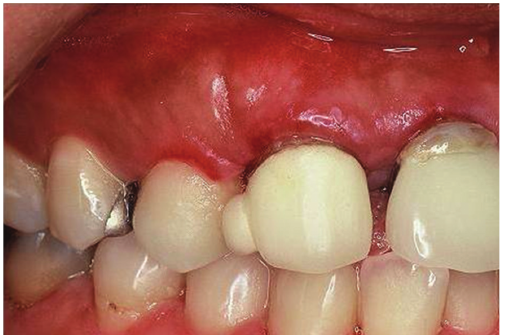
Figure 1: The initial examination revealed a patchy erythematous labial gingiva around teeth no. 7 and 8.